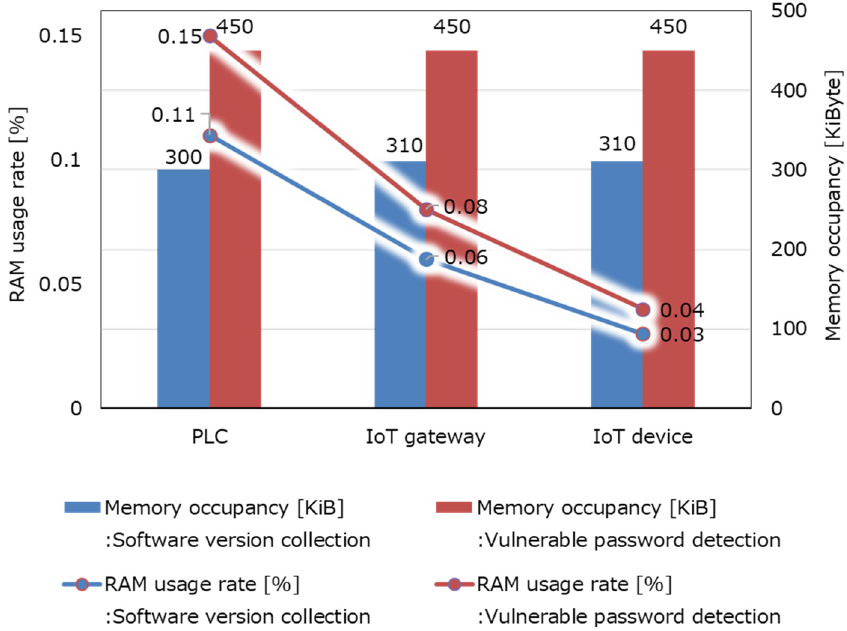
Figure 8. Performance test (memory consumption).